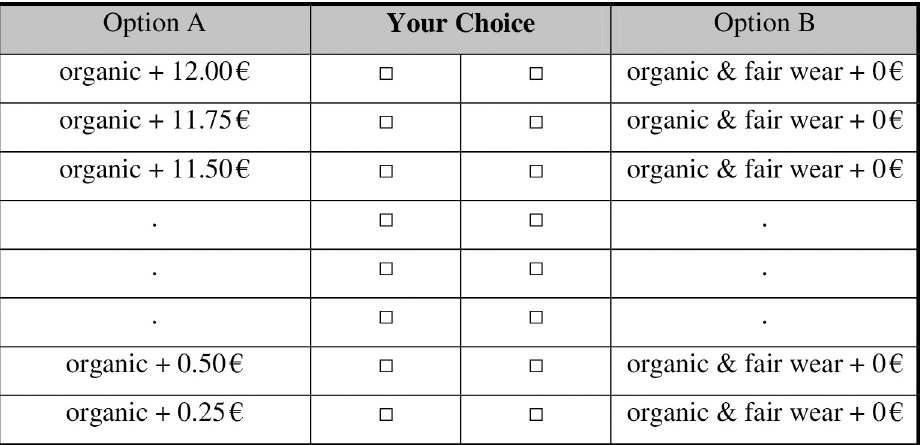
Fig 1. Price list as used in product organic. In the Organic Product treatment, subjects choose from a price list between a towel without an FWF certificate and money versus a towel with an FWF certificate and no additional money. The FWF certificate ensured controlled manufacturing standards for workers when sewing the towel. In any case, the towel is made from organic cotton.